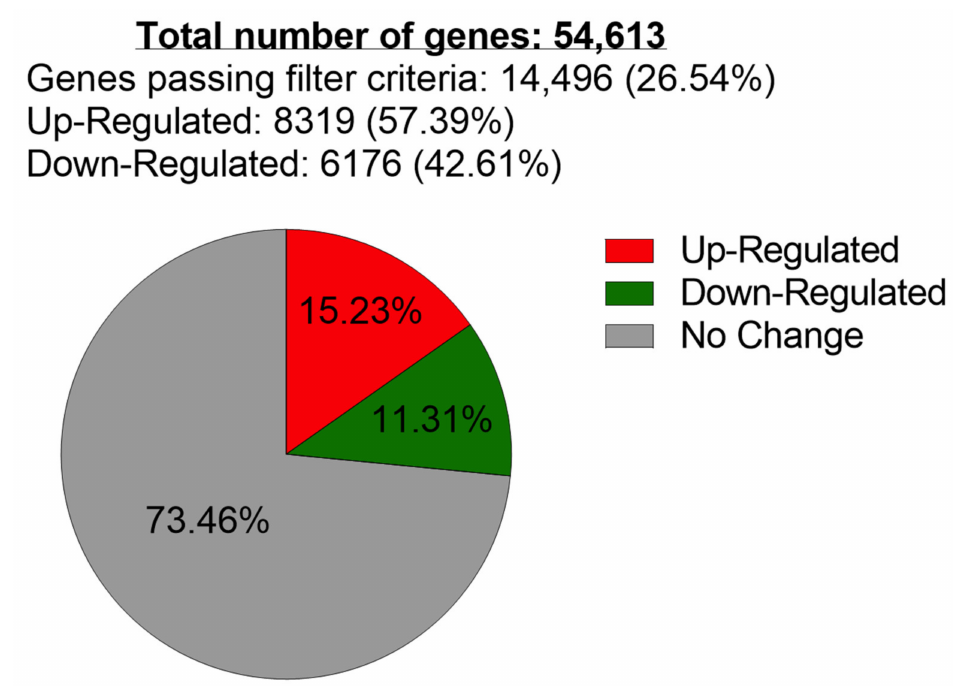
Figure 2. Poly E-treated PC-3 cell microarray gene expression filtering analysis. Pie chart presenta- tions of gene filtering analysis, with genes <2-fold expression-level change (in GREY), genes > 2-fold expression-level increase (in RED), and >2-fold expression level decrease (in